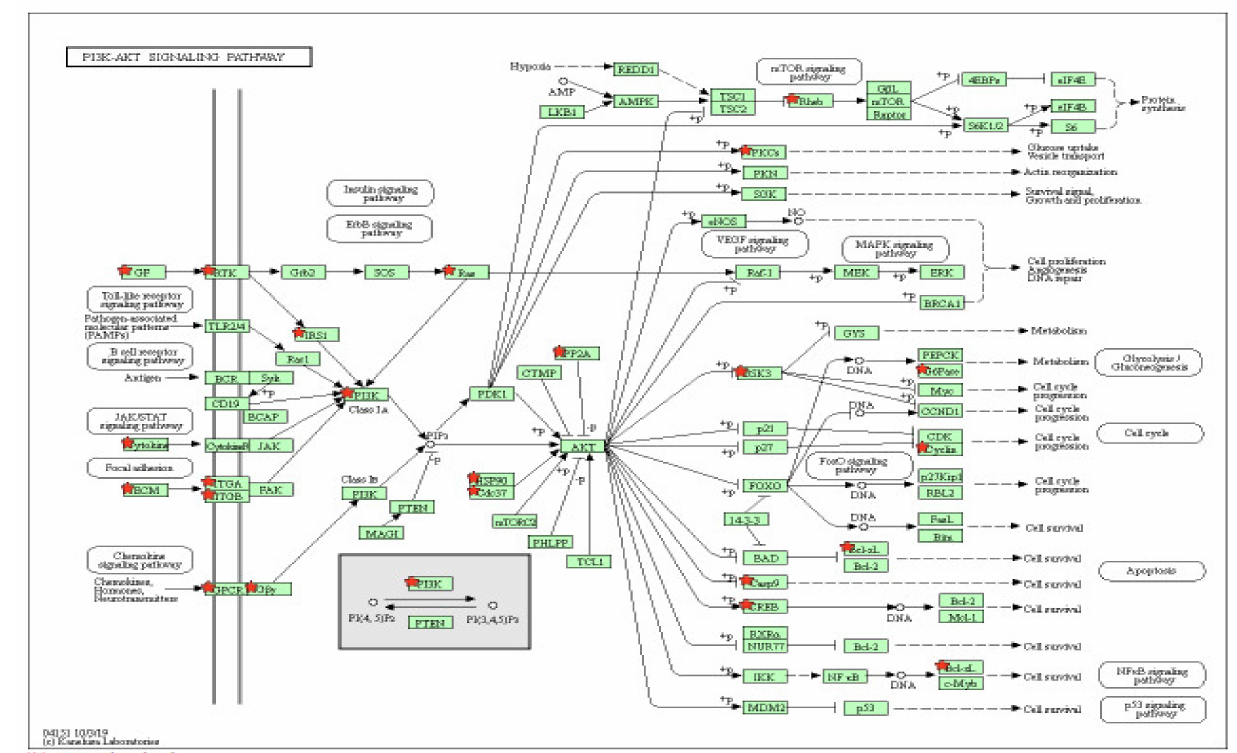
Figure 3. PI3K-Akt signaling